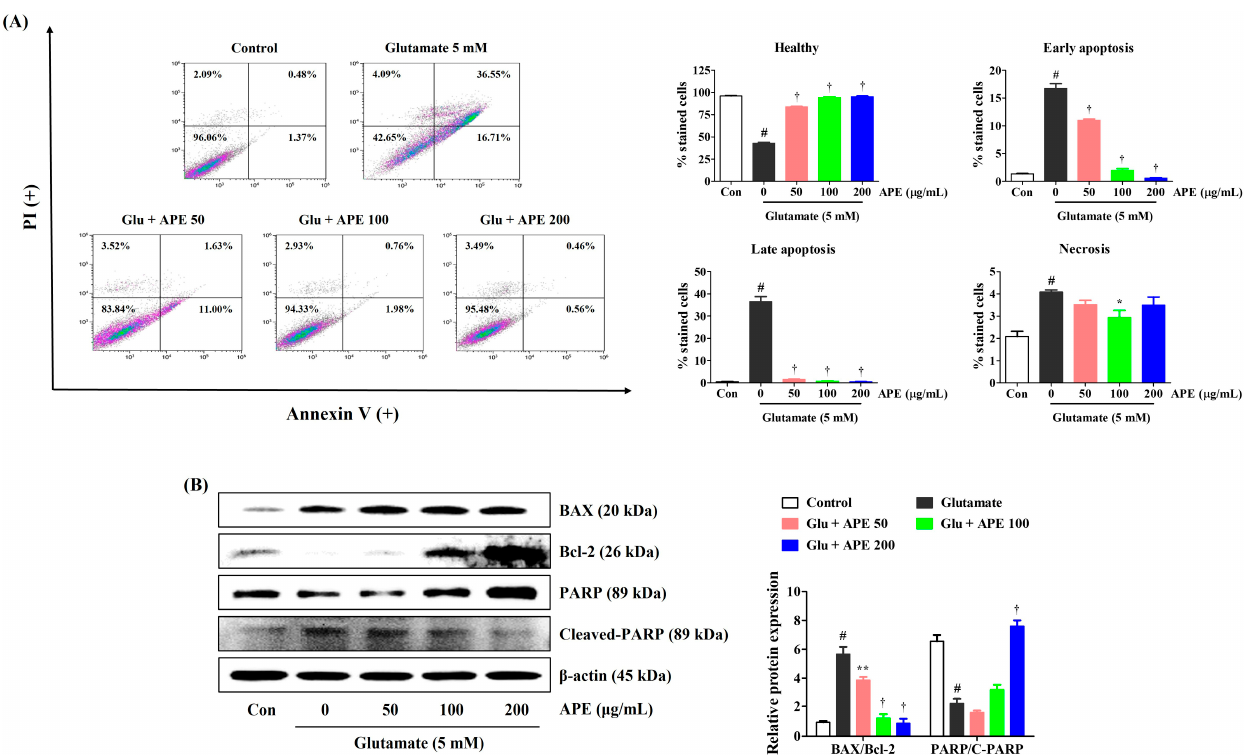
Figure 4. Effects of Arecae Pericarpium ethanol extract on glutamate-induced apoptosis in HT22 cells. Cells were pretreated with APE at concentrations of 50, 100, or 200 μ g/mL and then treated with glutamate (5 mM). ( A ) Apoptosis of HT22 cells was evaluated using flow cytometry. The image on the top right shows the percentage of healthy, early apoptotic, late apoptotic, and necrotic cells for each treatment group. ( B ) The expression levels of BAX, Bcl-2, PARP, and cleaved-PARP were determined by Western blot analysis. Control was non-treated cells. Blot images represent the three independent experiments. Data were presented as mean ± standard error of the mean. Statistical significance was set at # p < 0.05 (vs. control), * p < 0.05, ** p < 0.01, and † p < 0.001 (vs. glutamate). APE, Arecae Pericarpium ethanol extract; BAX, Bcl-2-associated X; Bcl-2, B-cell lymphoma 2; Con, control; Glu, glutamate; PI, propidium iodide; PARP, Poly(ADP-ribose)